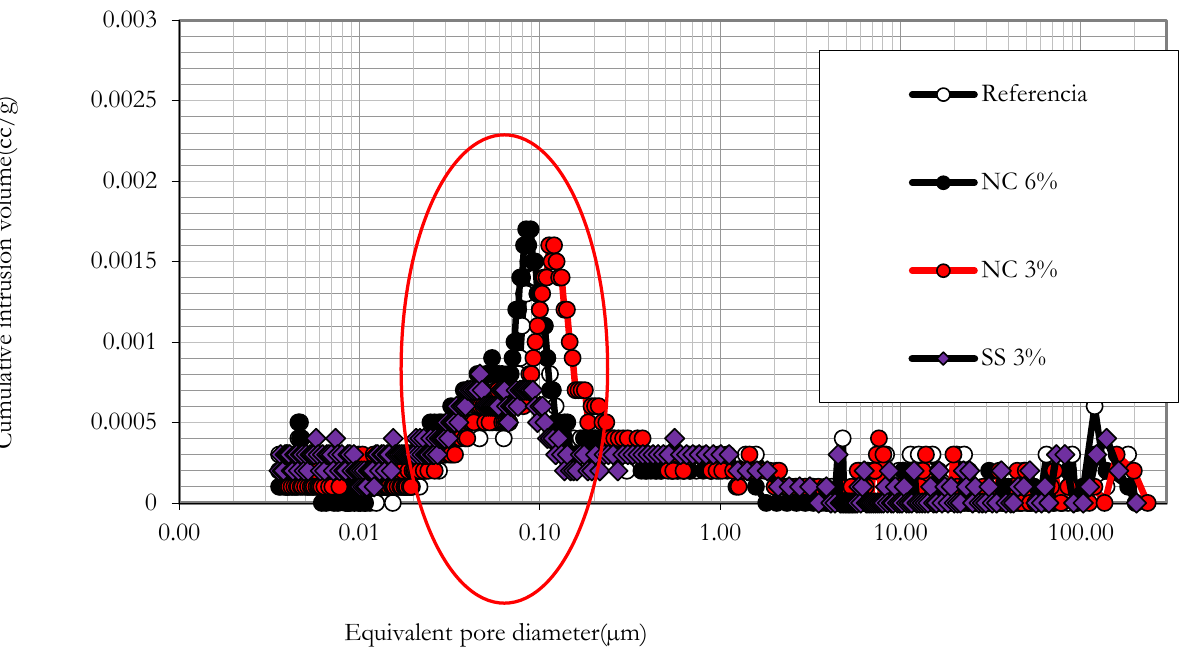
Figure 4. Mercury intrusion volume (cc/g).